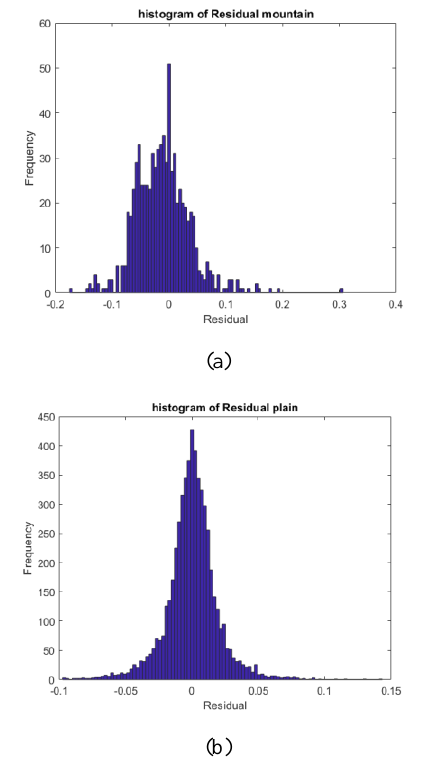
Figure 7 . Residual error histogram of the regression method in Fars province (a) mountain area, (b) plain area.